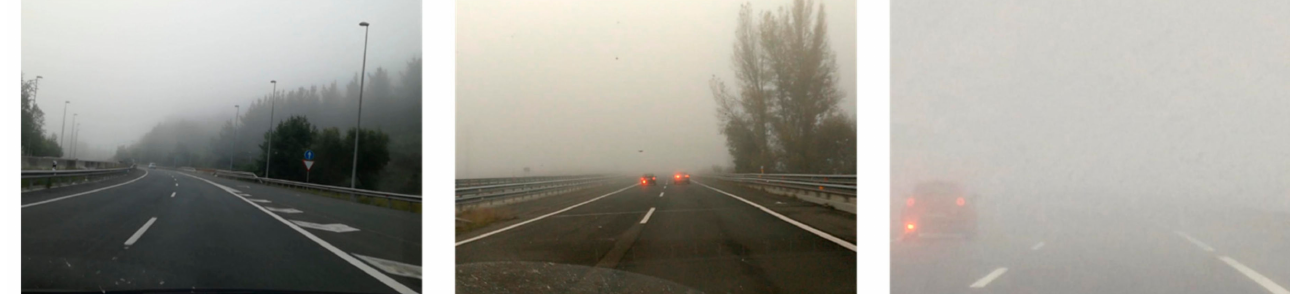
Figure 2. The Ceit-Foggy dataset. Sample images showing the annotated three different fog levels; from left to right: light fog, moderate fog and heavy fog.